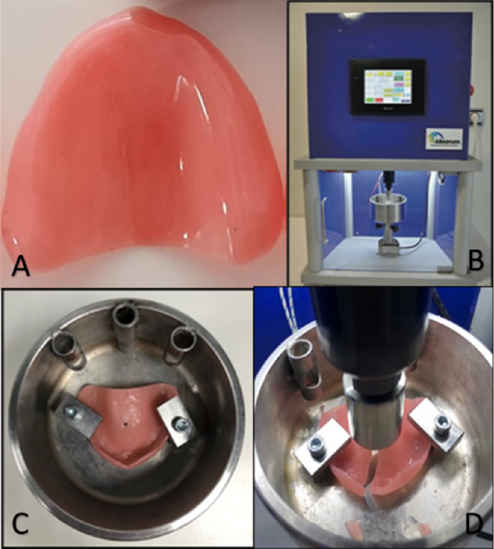
Figure 7. Examples of ( A ) acrylic base (control); ( B ) CS ® Dental Testing Machine; ( C ) support of the acrylic base; ( D ) simulated movement of dynamic mastication forces.